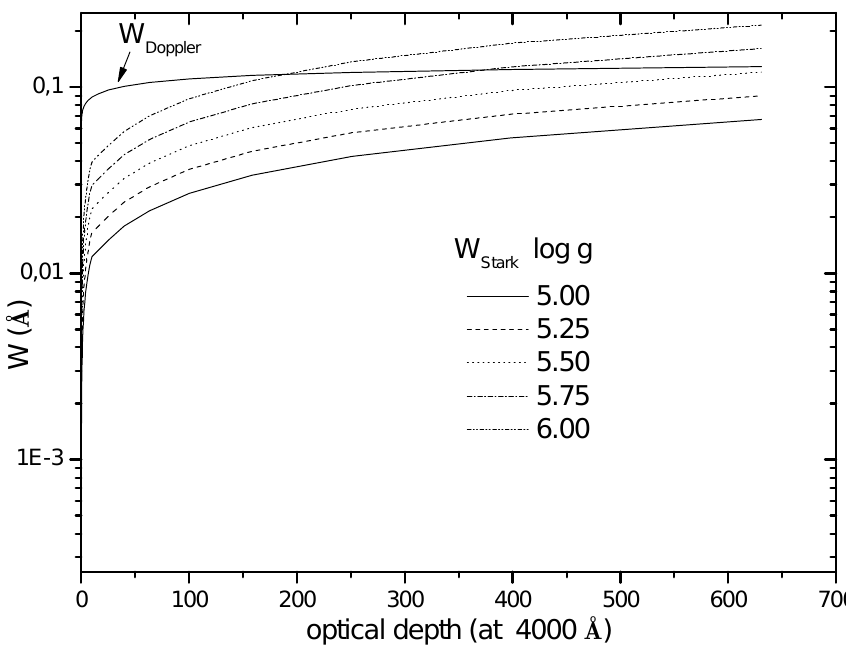
Figure 2. Stark and Doppler widths for Ar II ( 3 P) 3d 4 D 5/2 –( 3 P) 4p 4 P o as a function of atmospheric layer temperature. Stark widths are shown for five values of model gravity log g = 5 − 6, T ef f = 22,000 K.